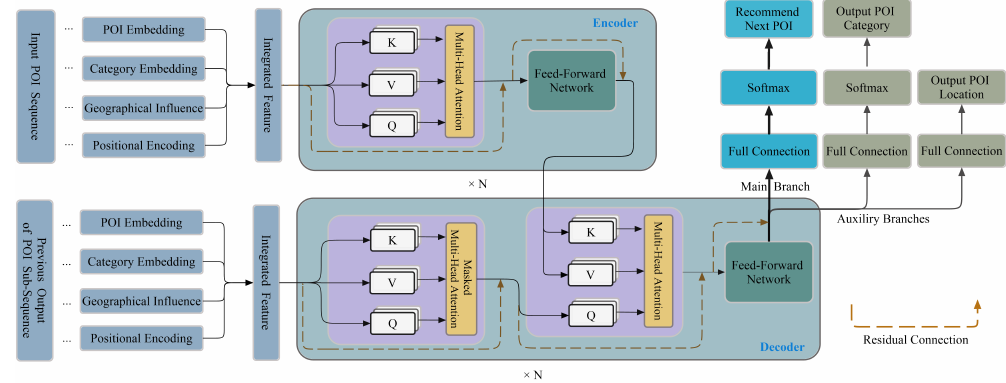
Figure 1. The architecture of